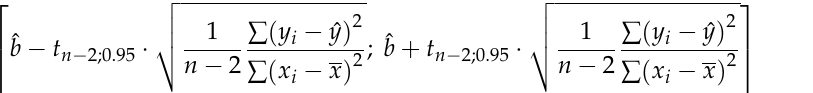
Table 5. Results of the computing confidence bands (confidence intervals) of variables used in Figure 3.